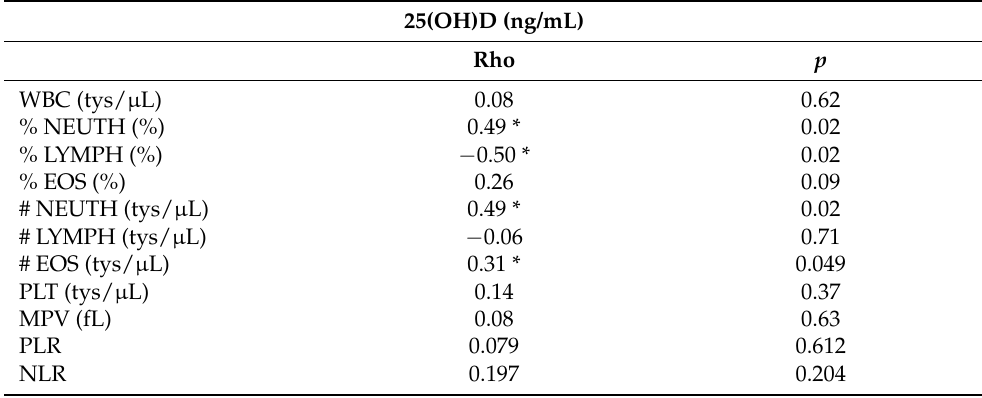
Table 5. Correlations between 25(OH)D concentration and hemogram